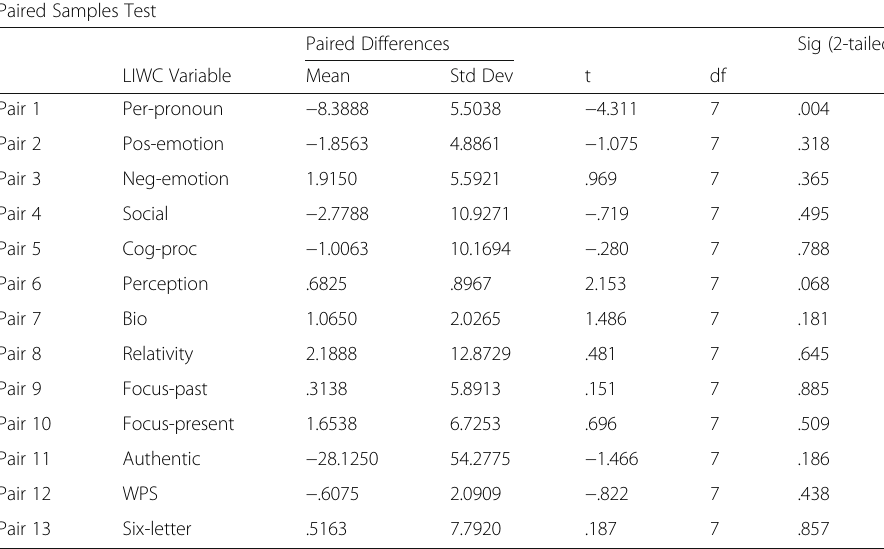
Table 6 LIWC social presence measures before/after intervention 3 Paired Samples Test